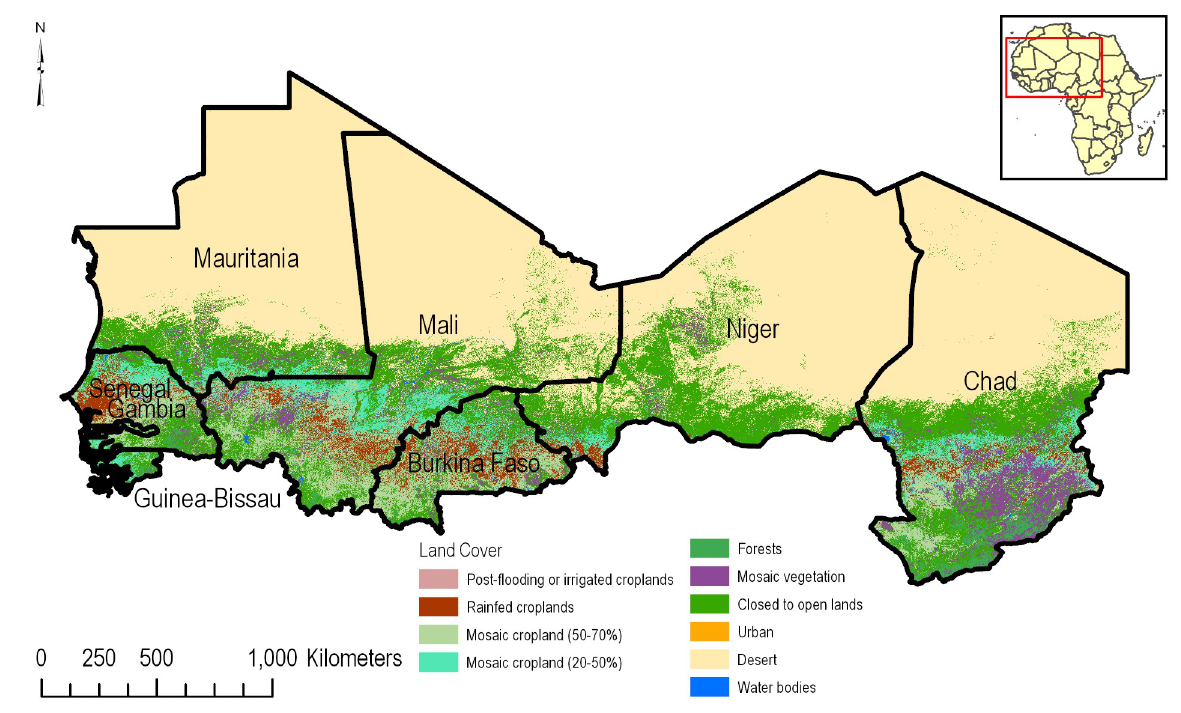
Fig 2. European Space Agency GlobCover land use [8] depicting the main land use classes in the western Africa CILSS countries.